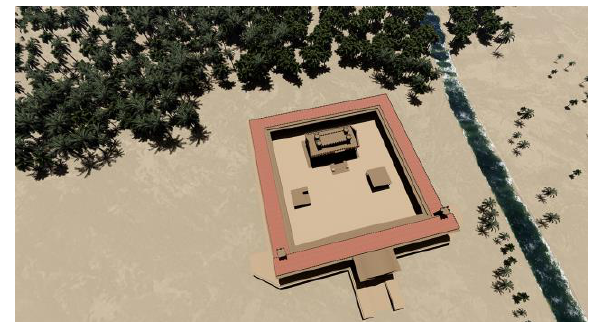
Figure 4. The temple of Bel stood in the center of a large temenos lined with